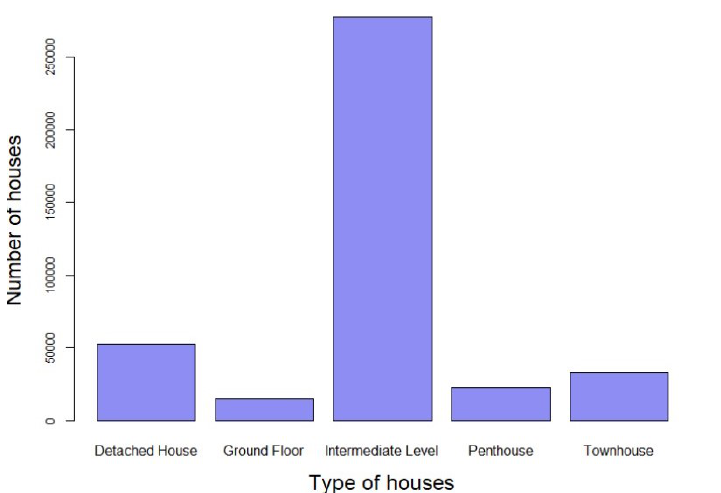
Figure 4. Distribution of number of dwellings according to nature of